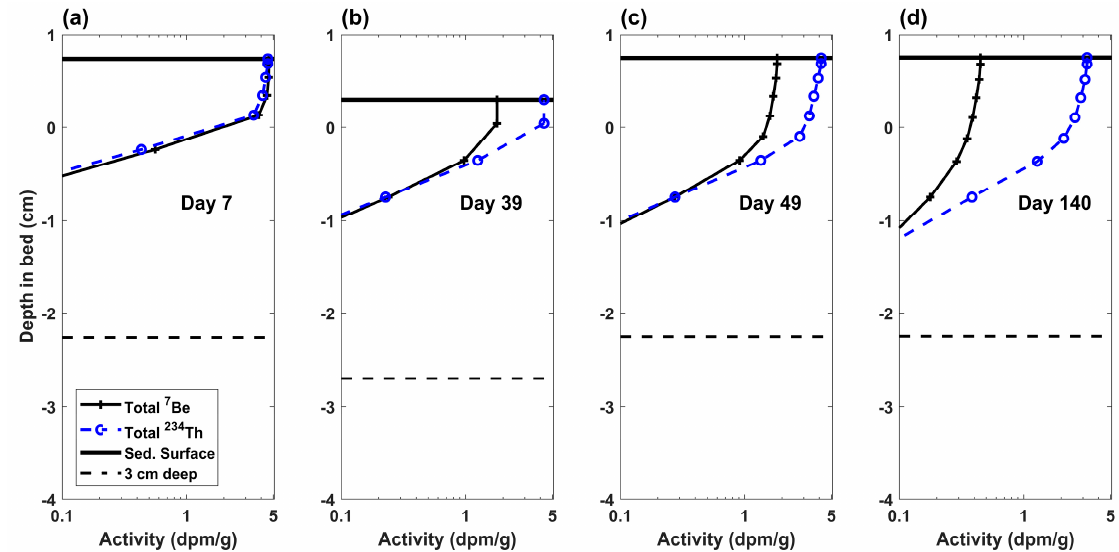
Figure 3. Vertical profiles of seabed radioisotope activities at four instances for Case 1. ( a ) Day 7 after initial deposition, ( b ) Day 39 at peak of a resuspension event, ( c ) Day 49 after redeposition, and ( d ) Day 140 during the extended quiescent period. Solid black lines represent bed surface and thick dashed lines represent three centimeters deep in the bed. The bed height prior to initial deposition was defined as z bed = 0.